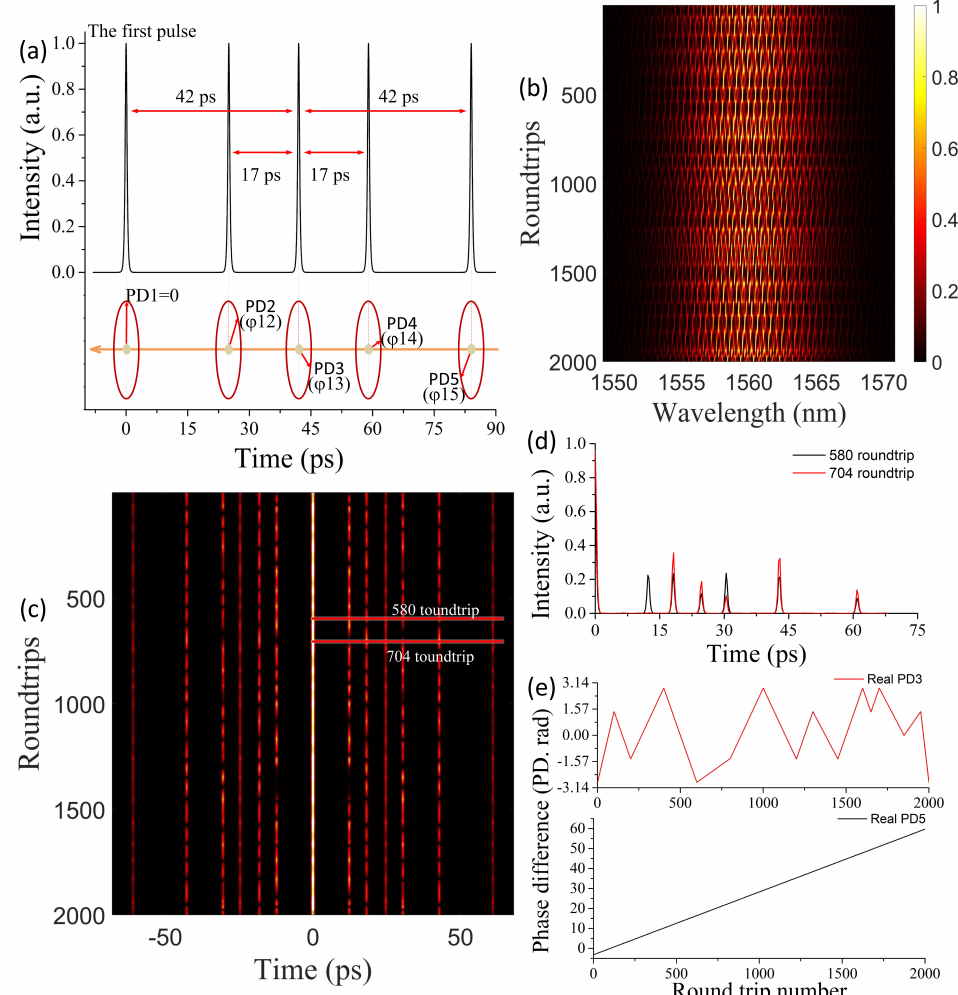
Figure 3. ( a ) Graphical representation of five-soliton molecules. ( b ) The testing TS-DFT (time-stretch dispersive Fourier transformation). ( c ) The autocorrelation trajectories of TS-DFT. ( d ) Comparison of two autocorrelation trajectories. ( e ) Two kinds of phase differences (PDs) evolution as representatives containing oscillating and the diverging sliding phases corresponding Real PD3 and